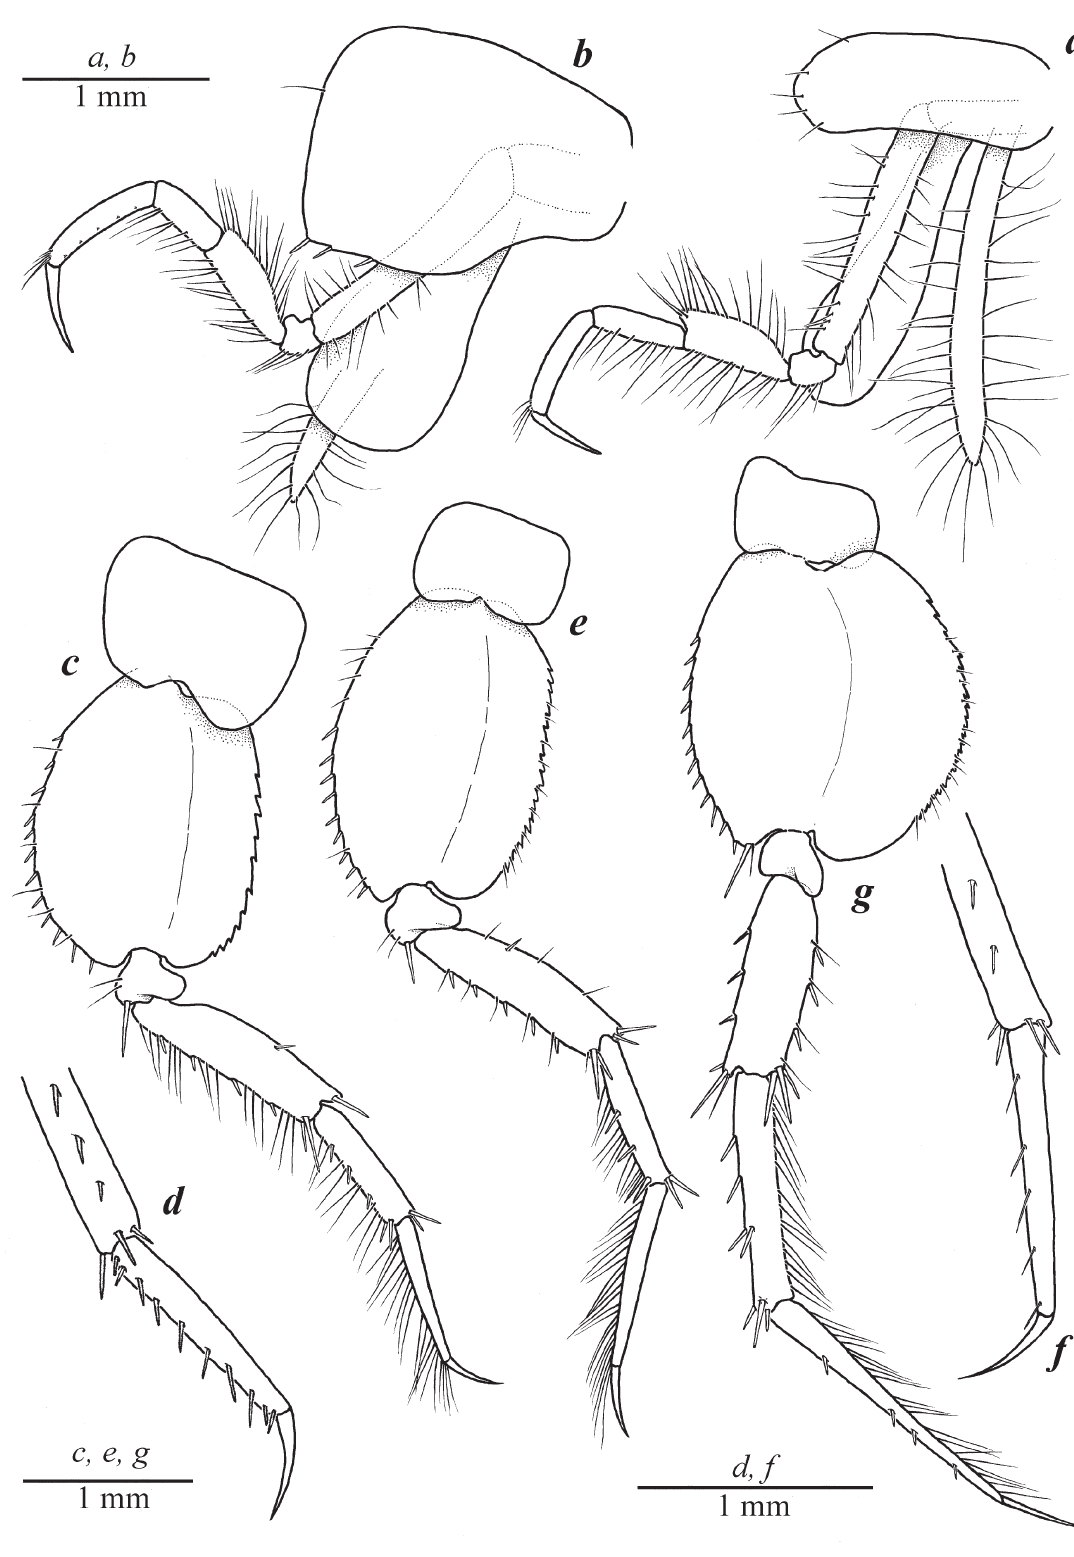
Fig. 4. Liljeborgia associata sp. nov., female (LEMMI) from Vostok Bay of the Sea of Japan. a . Pereopod 3. b . Pereopod 4. c . Pereopod 5. d . Distal segments of P5 . e . Pereopod 6. f . Distal segments of P6 . g . Pereopod